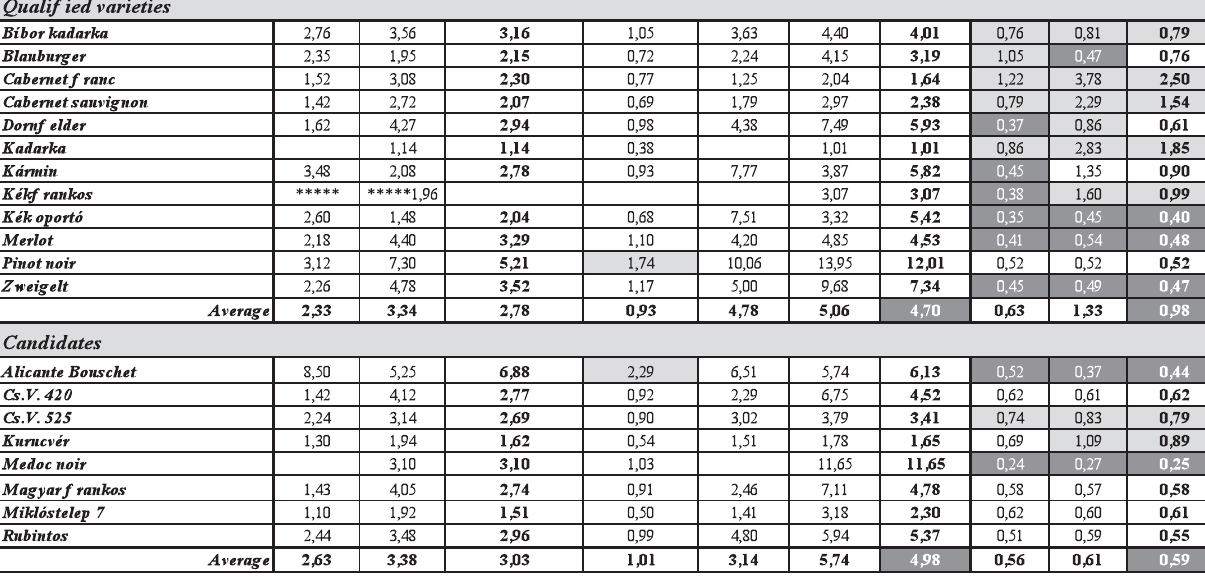
’Dunagyöngye’ and ’Pannon